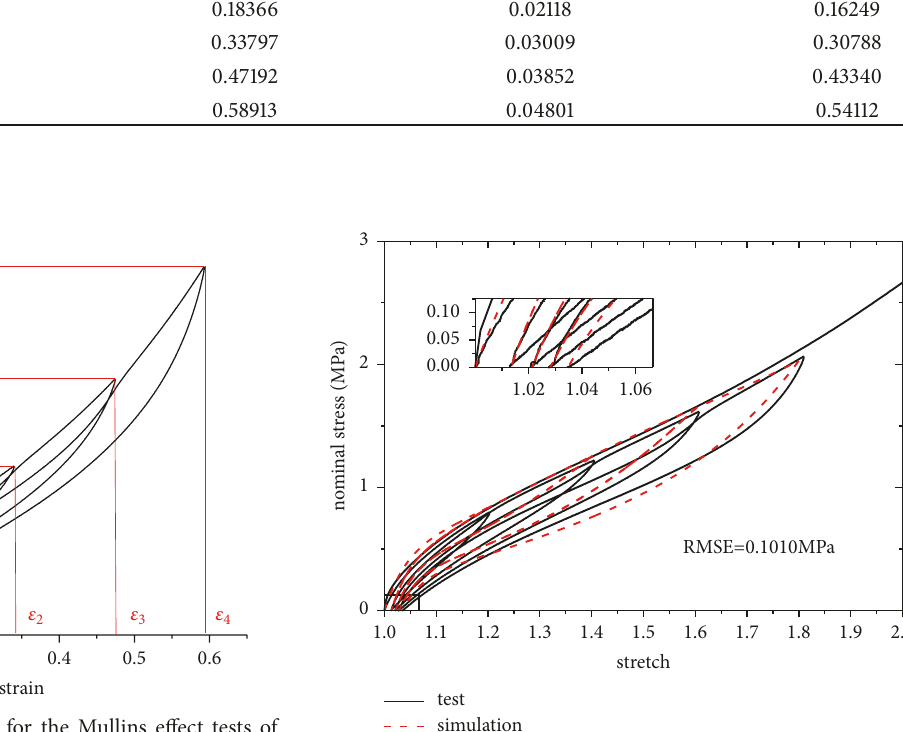
Figure 7: True stress–strain curve for the Mullins effect tests of NSBR5.